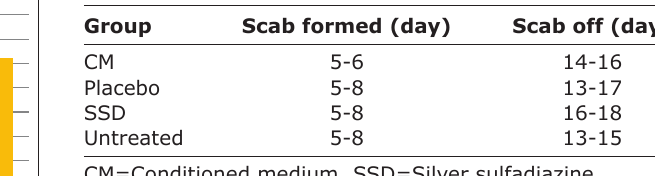
Table-3: Days of scab formation and the scab off from the wound.